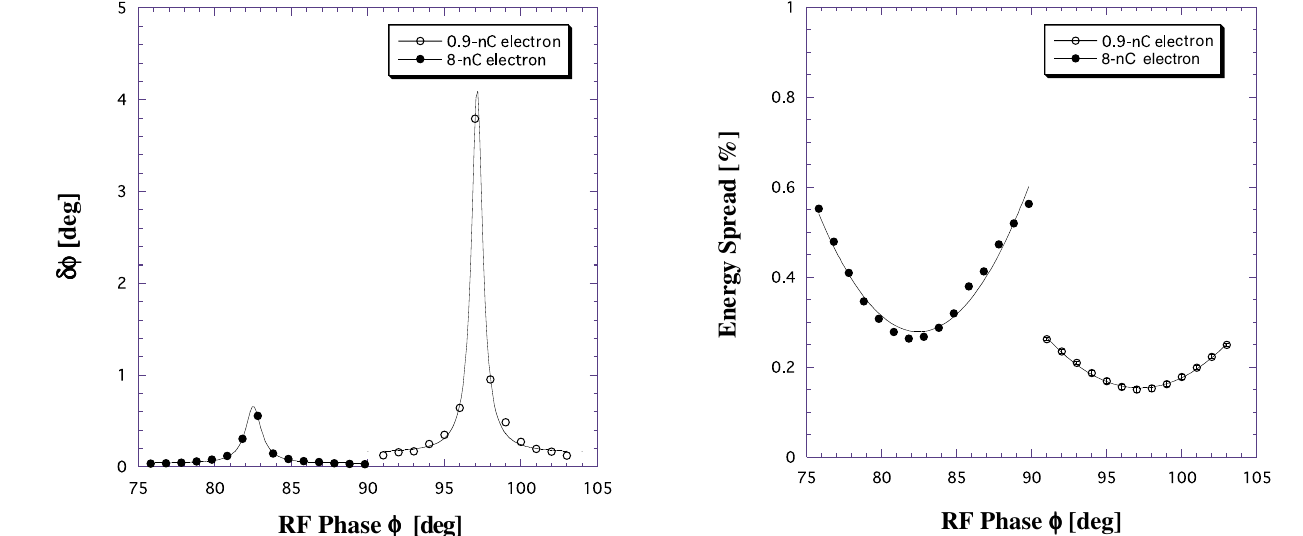
FIG. 9. (Color) Variations of the energy spread depending upon the rf phase of the booster klystron obtained for the 0.9 and 8- nC electron beams. The solid lines show curves with a quadric least-squares fitting procedure.